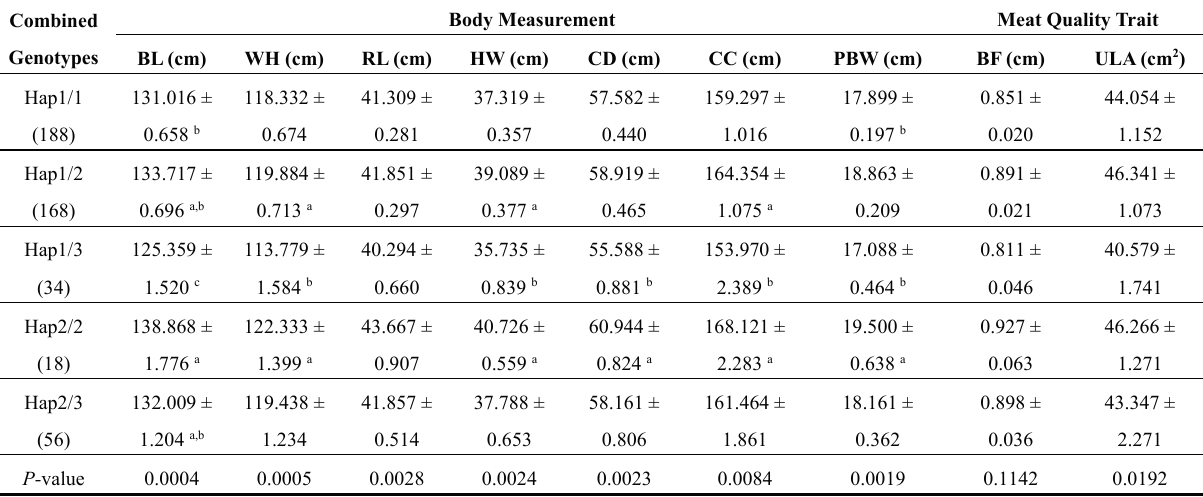
Table 5. Associations of haplotypes with body size traits in Qinchuan cattle. Note: Values are shown as the least squares means ± standard error. a–c Means with different superscripts are significantly different ( p < 2.78 × 10 − 3 ) after Bonferroni correction. Body length (BL), withers height (WH), hip height (HH), rump length (RL), hip width (HW), chest depth (CD), chest circumference (CC), and pin bone width (PBW), fat thickness (BF) and ultrasound loin muscle area